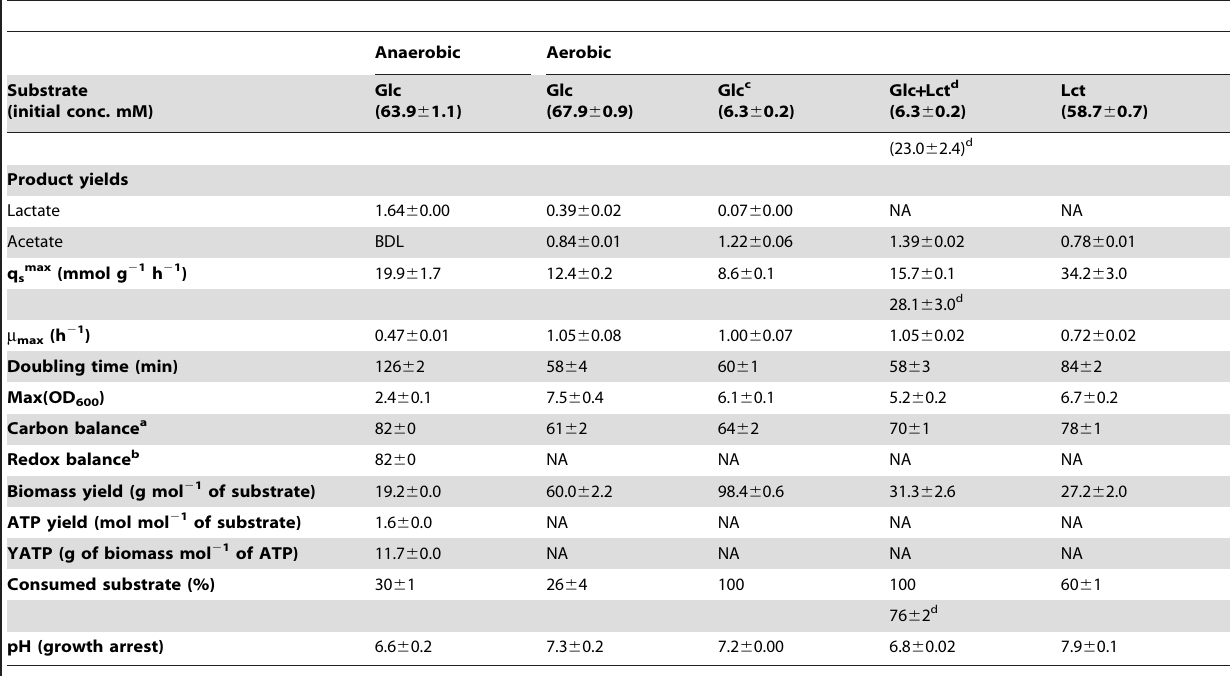
Table 1. Product yields, carbon and redox balances, growth and energetic parameters, total substrate and pH values determined at the time-point of maximal biomass achieved by S.